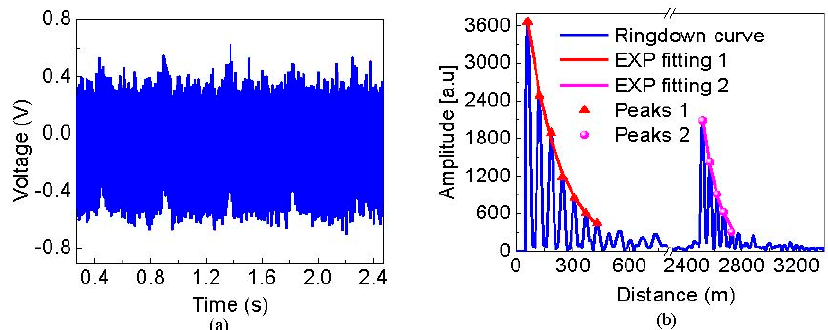
Figure 3. The typical differential interference signal without strain applied. ( a ) The time-domain signal sampled by the DAQ; ( b ) the space-domain ringdown signal obtained by performing fast Fourier transform of the time-domain signal. 1 represents sensing point one, 2 represents sensing point two.